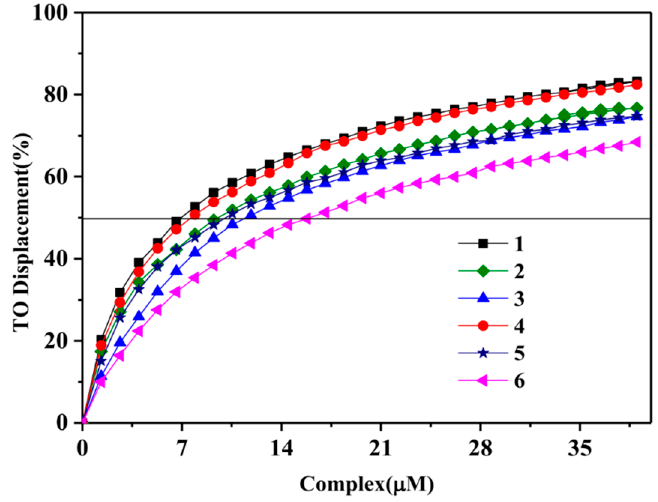
Figure 4. The DC 50 values of Ru(II) complexes. The relative TO displacement for c-myc G-quadruplex substrates as a function of increasing concentration of the specified complexes is shown.